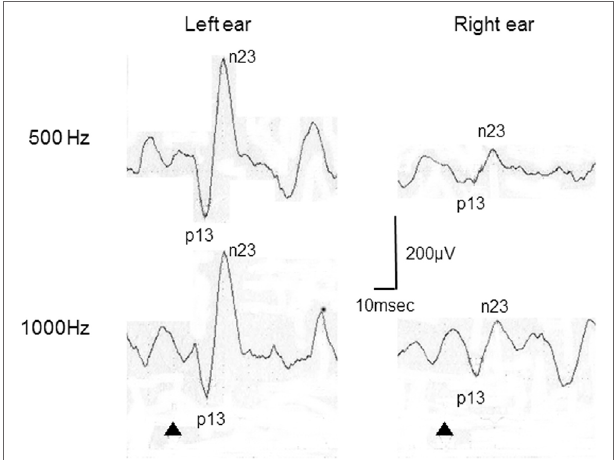
FigUre 1 | rOc curve for prediction of Ménière’s disease patients from other vestibular disease patients . The area of under the ROC curve was 0.75.